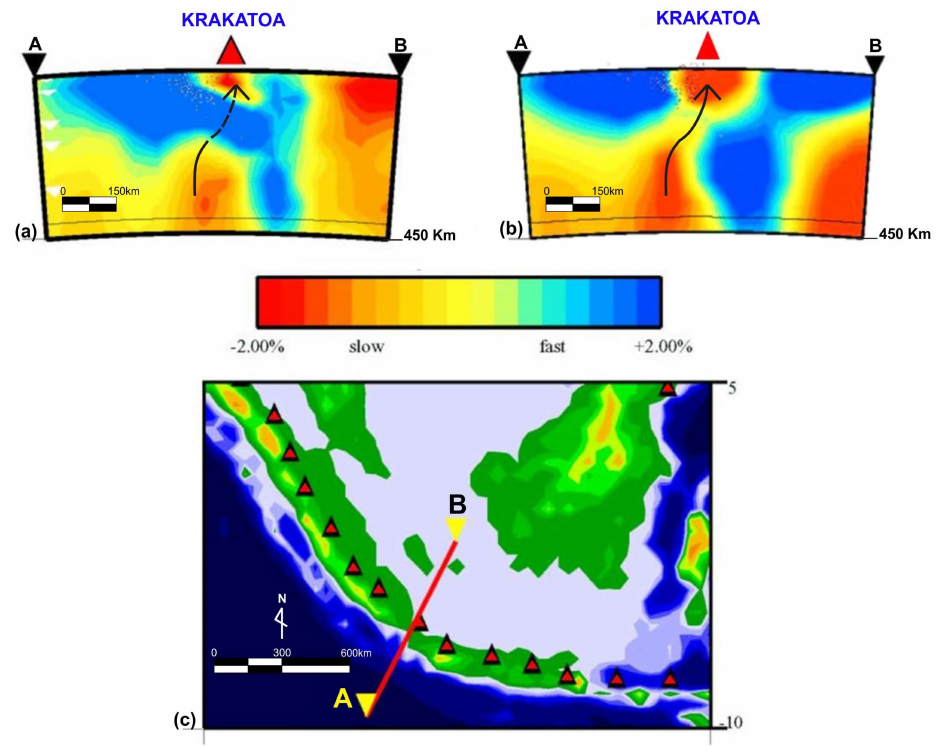
Figure 7. ( a ) Vertical section of P-wave model across Krakatoa Volcano. Tomogram is plotted as velocity perturbations relative to the ak135 velocity model [34]. The thin line in the cross section indicates the 410-km mantle discontinuity and the arrow depicts hot mantle upwelling. ( b ) Same as ( a ), but based on an S-wave model. ( c ) Index map, showing location of Krakatoa Volcano and A-B cross section line. Note the thinning in the subducted slab in the upper mantle below Krakatoa, which may be due to: (i) intrusion of hot mantle upwelling, (ii) strong slab pull in the study region [11,13], and (iii) the change from oblique subduction in Sumatra to frontal subduction in